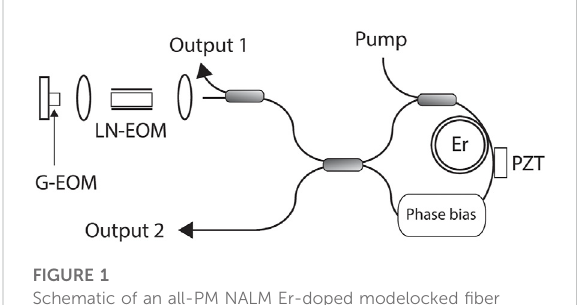
FIGURE 1 Schematic of an all-PM NALM Er-doped modelocked fi ber laser with fast graphene electro-optic modulator (G-EOM) and lithiumniobate electro-opticmodulator(LN-EOM) for f ceo and f rep control, respectively, adapted from ref.